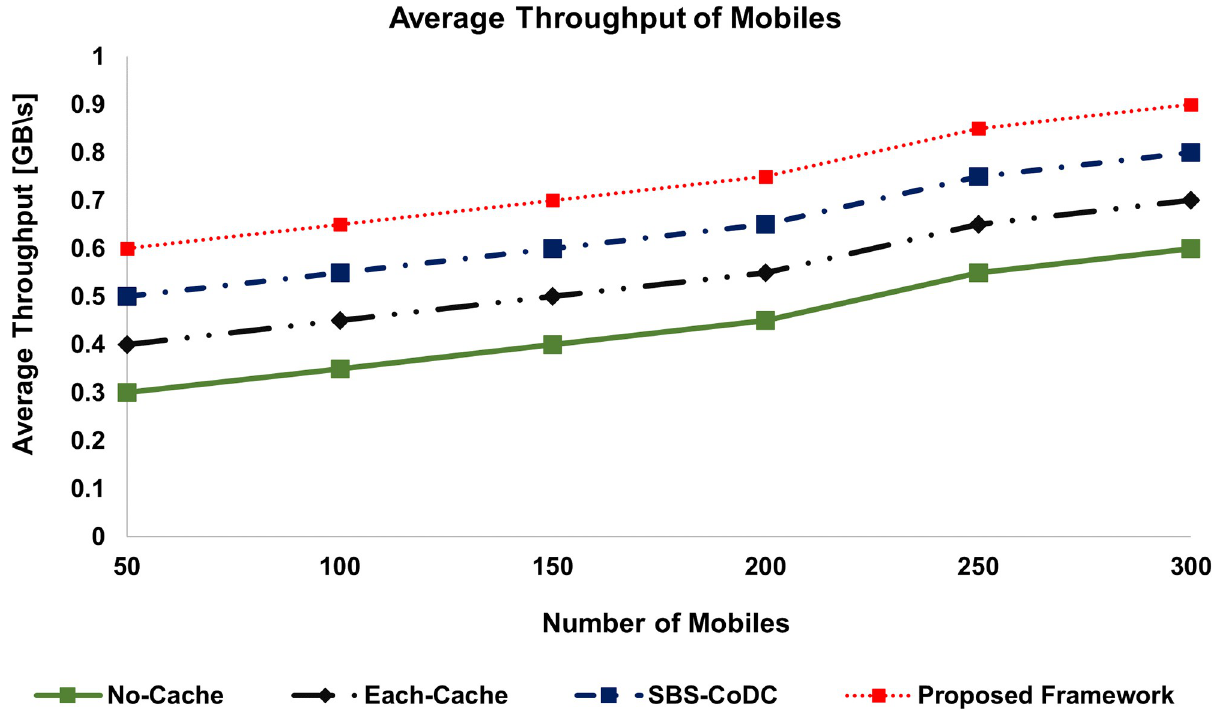
Fig 8. Comparison average throughput of MSs.